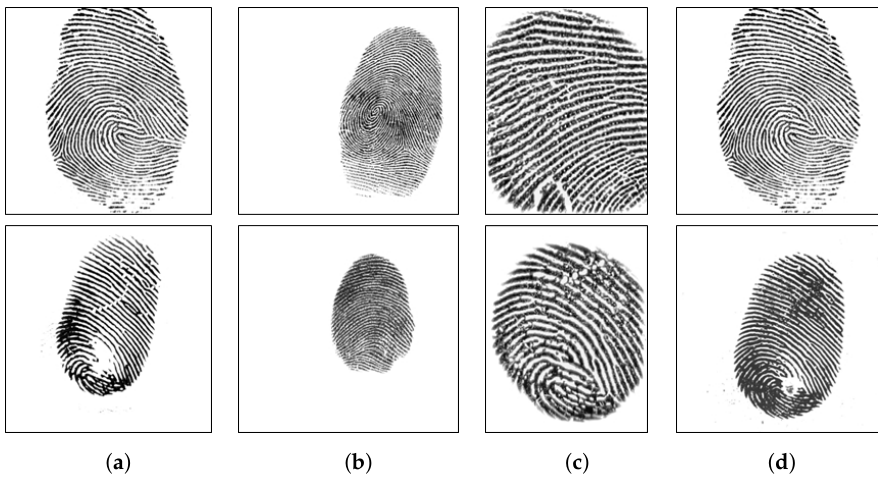
Figure 7. Sample images of LivDet 2013. The top row includes live samples; the bottom row includes fake samples. Samples are from Biometrika ( a ) and ItalData ( b ) devices.